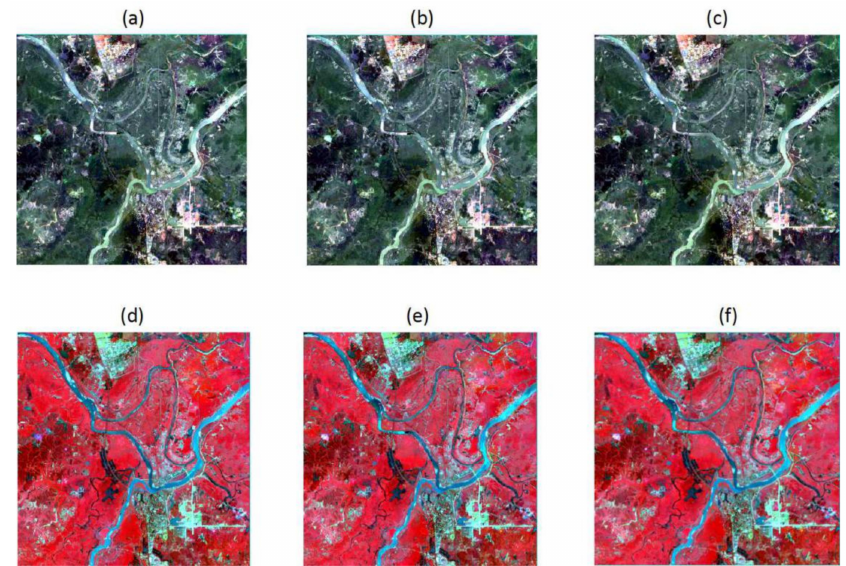
Figure 4. The comparison of actual images and predicted images using di ff erent spatiotemporal data fusion algorithms. Note: the upper row are true-color-composites of Landsat and Landsat-like images; the lower row are false-color-composites of Landsat and Landsat-like images; ( a , d ) are actual observed images; ( b , e ) are Landsat-like images predicted by ESTARFM; ( c , f ) are Landsat-like images predicted by the modified algorithm.